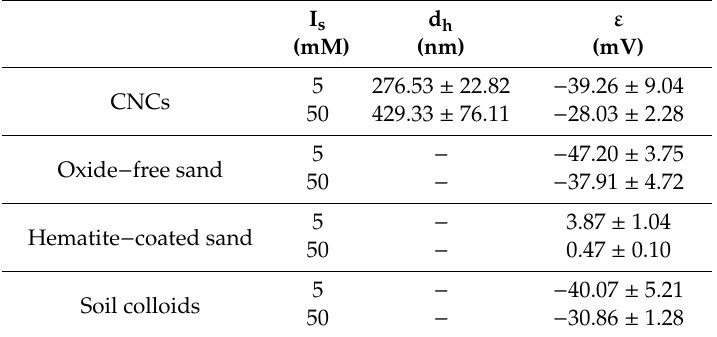
Table 3. Measured sizes and / or zeta potentials of colloids and porous media.